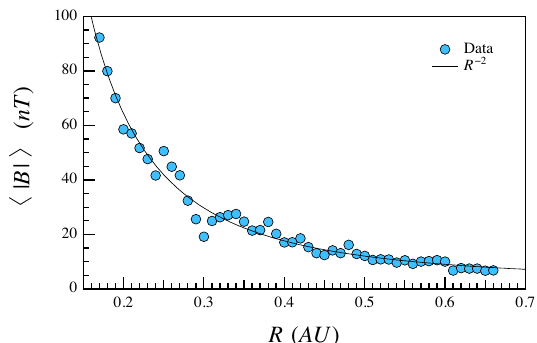
Figure 2. The average magnetic field intensity ( | B | ) as a function of the radial distance, R . The solid line is a power-law fit according to expected scaling with the distance, i.e., | B | ∼ R − 2 .